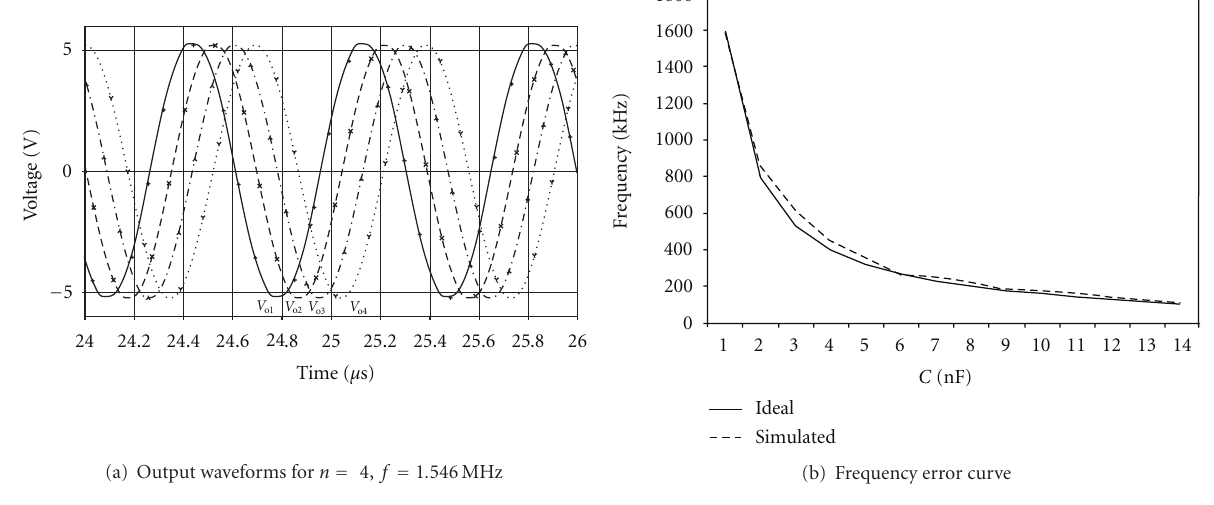
Figure 8: Simulation results for circuit II.